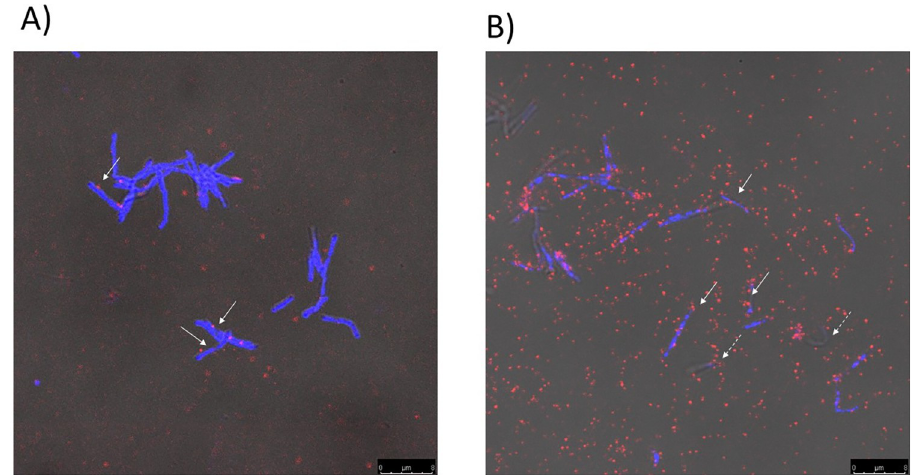
Fig 1. Immunofluorescence microscopy of phage infected Msm cells, A) 30 and B) 120 mins post infection. Phages were identified using a polyclonal rabbit serum against gp17 capsid protein, and anti-rabbit ALEXA conjugated secondary antibody (red). The cells were localized using the nucleic acid staining dye DAPI, (blue). The phase contrast, DAPI and ALEXA-stained images were merged. The scale below represents 7.5 μ m. The arrows indicate cells with adsorbed phages. Broken arrows indicate cells that were not stained with